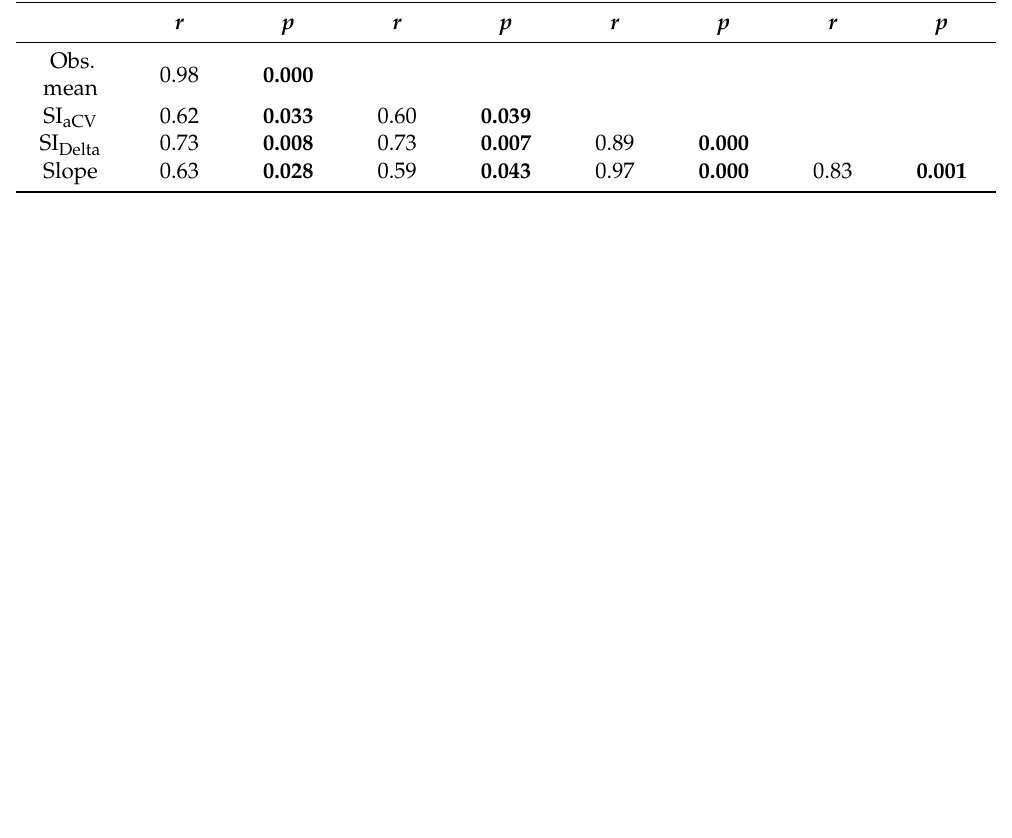
Table 4. Pearson correlation statistics for expected (from sole crops) and observed (intercrops) mean grain yield values, stability indices based on adjusted coefficients of variance (SI aCV ) and the yield differences (delta) between the two cultivation years 2017 and 2018 (SI Delta ), and the slopes for the linear regressions of expected vs. observed yields. r —Pearson correlation coefficient, p —significance (significant: p < 0.050 in bold), n = 12 for all correlations. Exp. Mean Obs. Mean SI